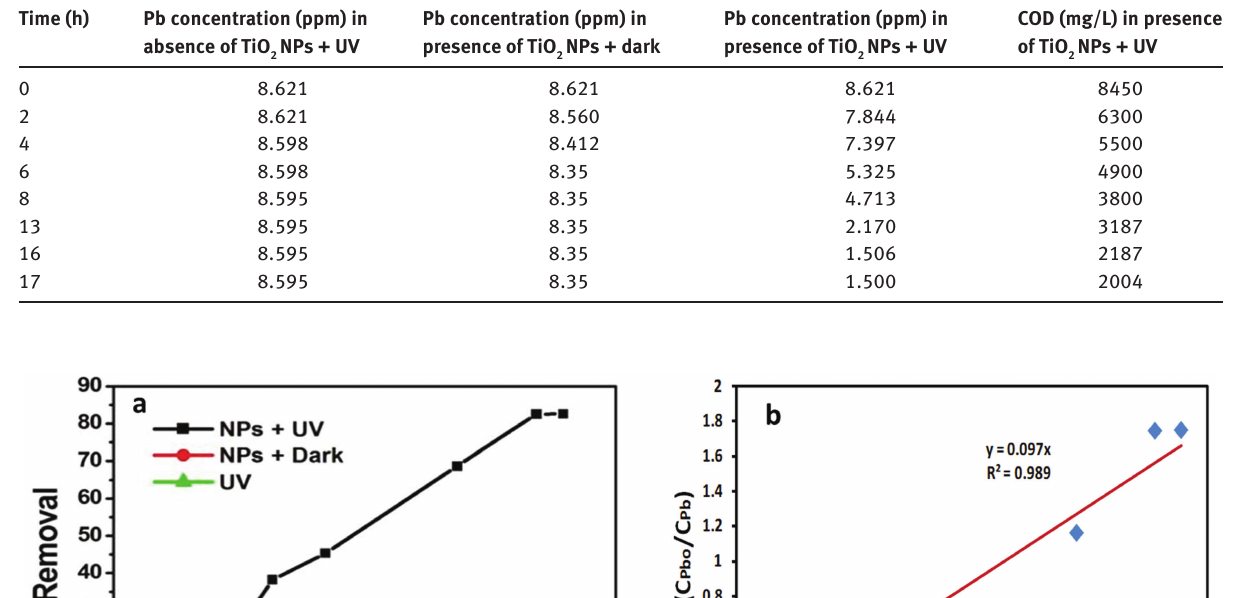
Table 3: ICP and COD values at different